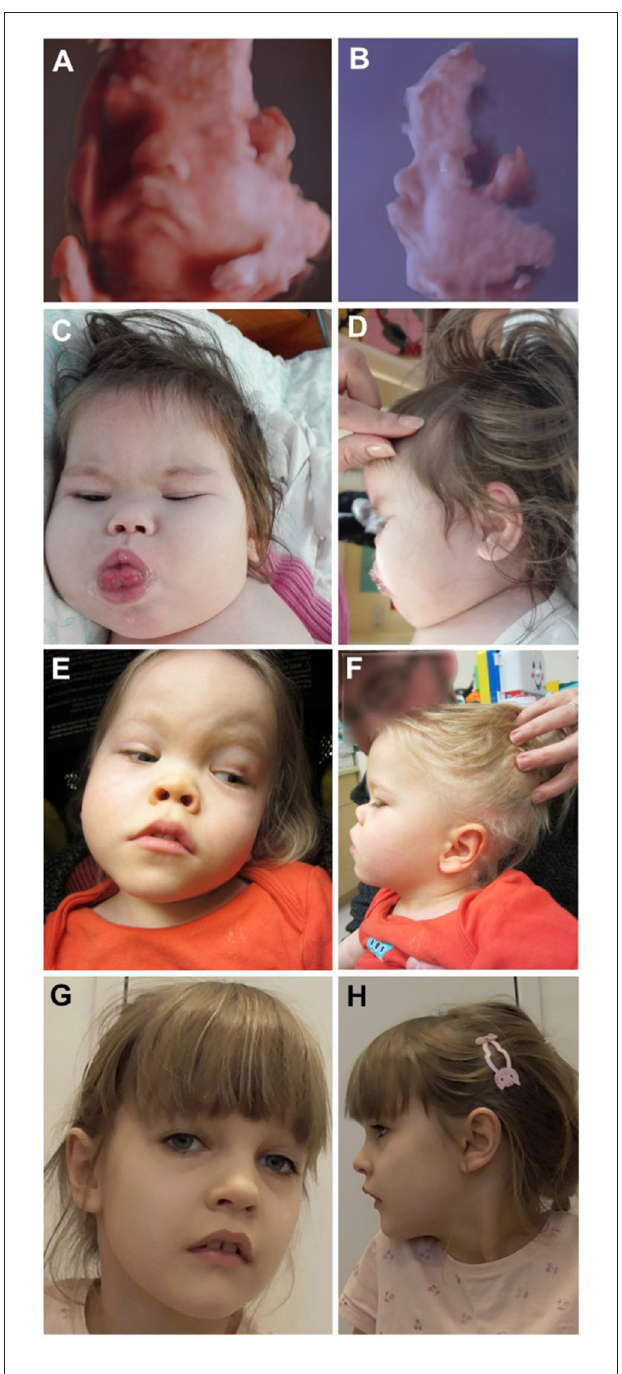
FIGURE 2 | (A) Prenatal 3D ultrasound of patient 2 at 34 weeks 2 days’ gestational age, frontal view showing carpe-shaped mouth with tenting of both upper and lower lip. (B) Prenatal 3D ultrasound of patient 2 at 34 weeks 2 days’ gestational age, lateral view showing craniofacial features with depressed nasal bridge, upturned nasal tip and prominent upper lip. (C) Facial features of patient 4 at age 10 months, frontal view showing depressed midface with full cheeks and prominent philtral ridges. (D) Facial features of patient 4 at age 10 months, lateral view showing deep-set eyes and low-set ears. (E) Facial features of patient 1 at age 3 years, frontal view showing high forehead, depressed midface, full cheeks, and tented mouth. (F) Facial